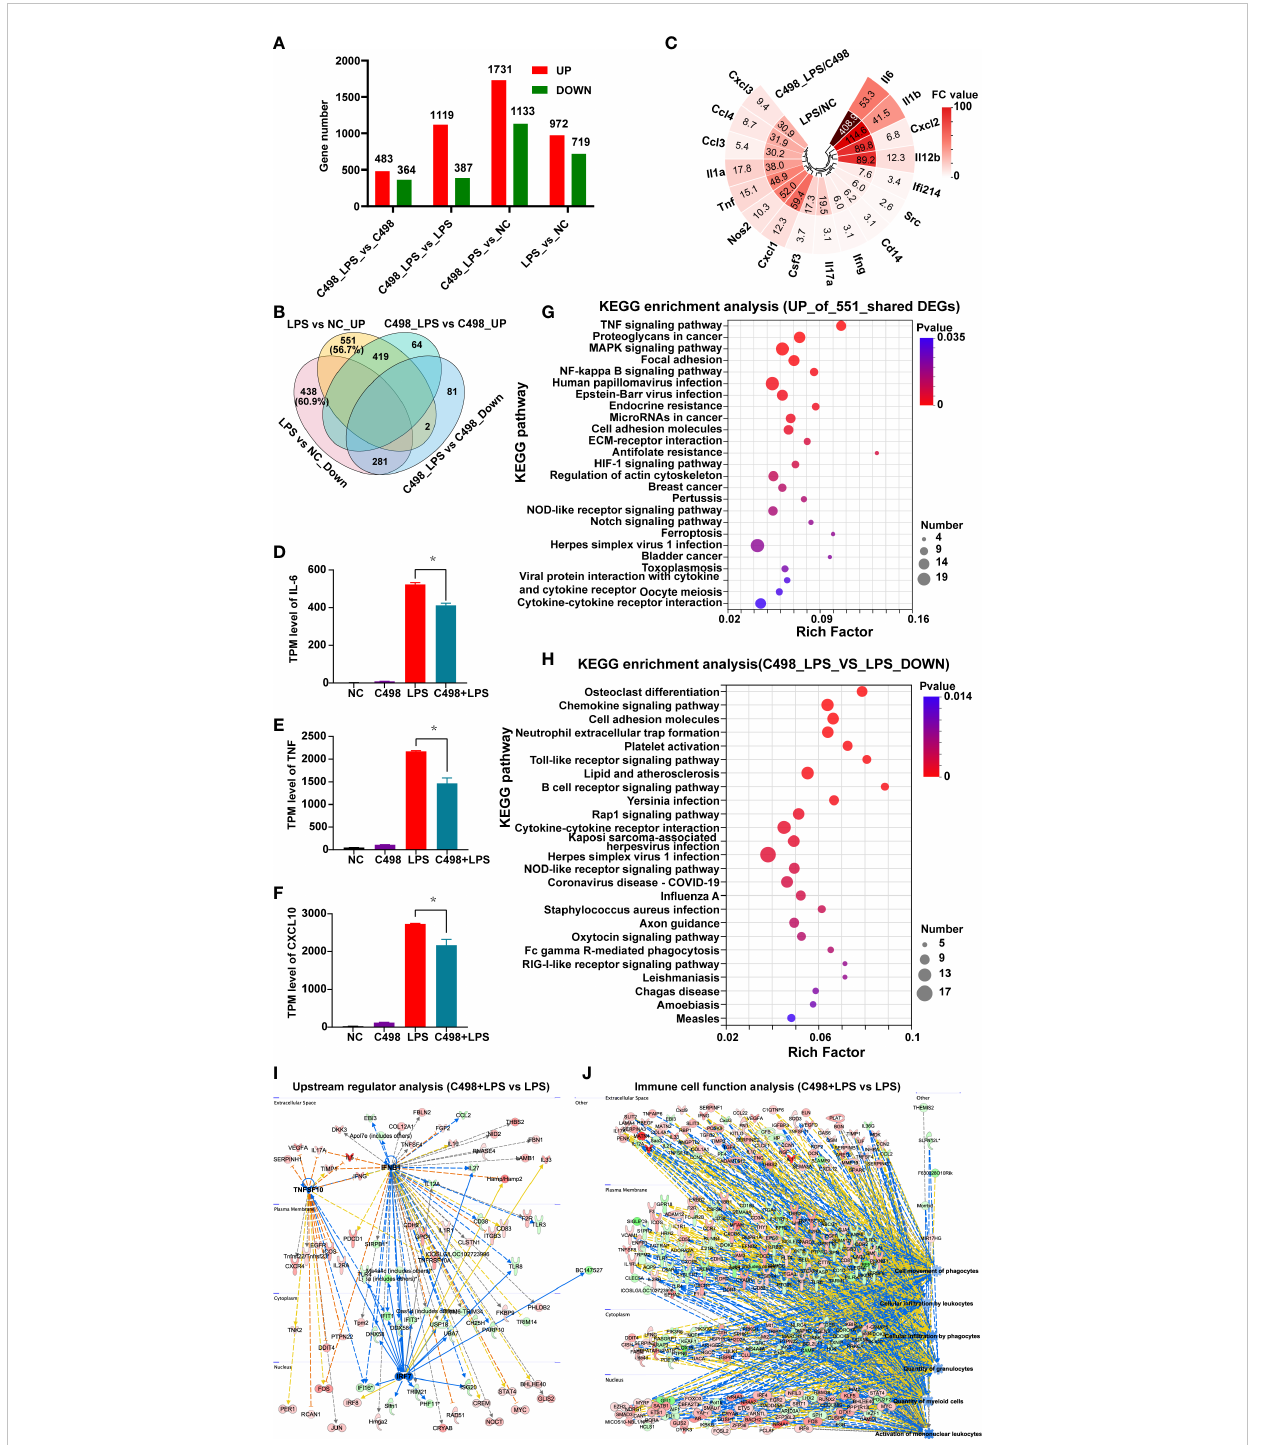
FIGURE 3 Anti-in fl ammatory effects of C498. (A) , DEGs among different treatment groups. Genes with fold change (FC) ≥ 2 and P-adjust ≤ 0.05 were considered as signi fi cantly differentially expressed genes. (B) Venn diagram of DEGs among indicated comparison groups. (C) Fold change values (FC) of canonical in fl ammatory factors enriched in 551 DEGs in (B) . D-F, The normalized expression (TPM levels) of IL-6 (D) , TNF (E) and CXCL10 (F) was graphed. *P < 0.05 is considered signi fi cant. (G) , The top 25 KEGG enrichment analysis of the upregulated 511 DEGs in (B) . (H) , The top 25 of KEGG enrichment of downregulated DEGs between C498_LPS vs LPS groups. (I) , The decreased upstream regulators IRF7-IFNB-TNFSF10 related networks of C498_LPS vs LPS in IPA analysis. (J) , The decreased immune cell traf fi cking functions of C498_LPS vs LPS in IPA